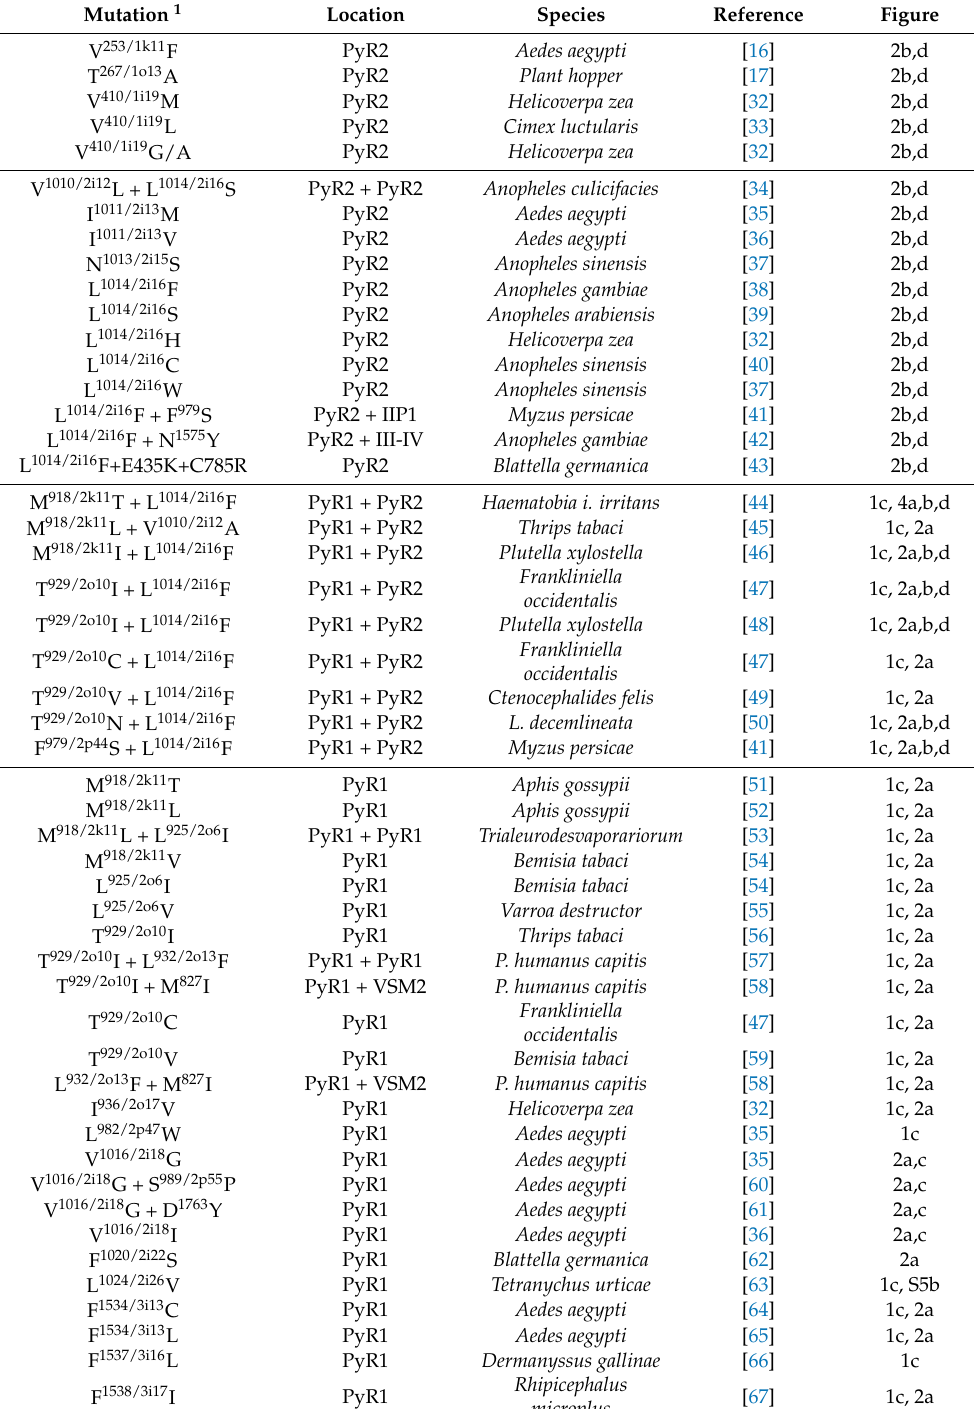
Table 1. Kdr mutations in the PyR1 and PyR2 sites of insect sodium channels. Mutation 1 Species Reference